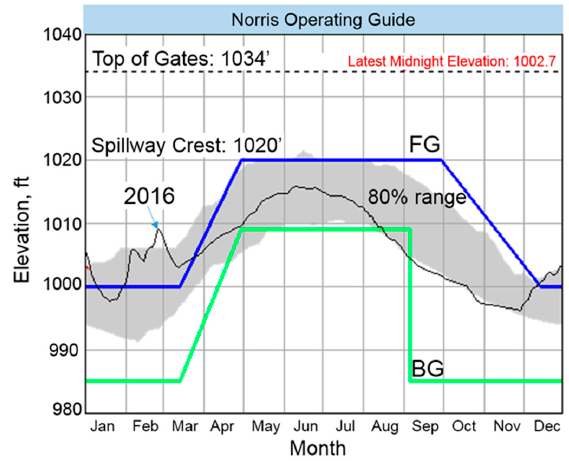
Figure 2. Current Norris Reservoir Operating Guide. FG is the flood guide and BG is the balancing guide [34]. The shaded area is the 80 percent probability.